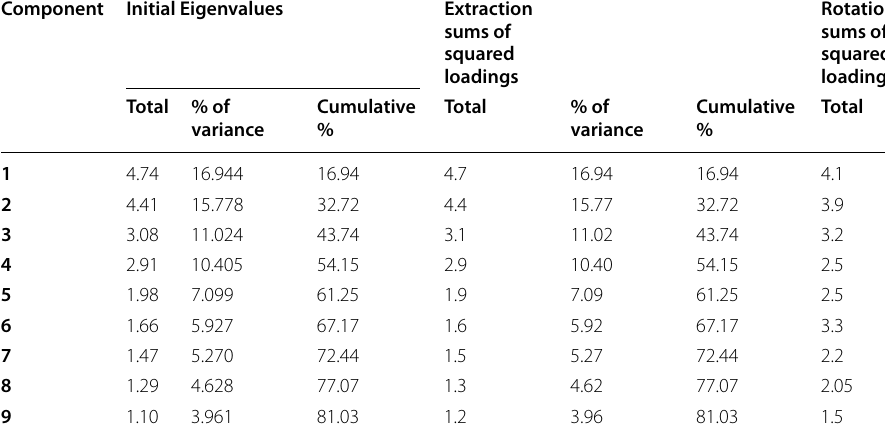
Table 4 Part of total variance explained